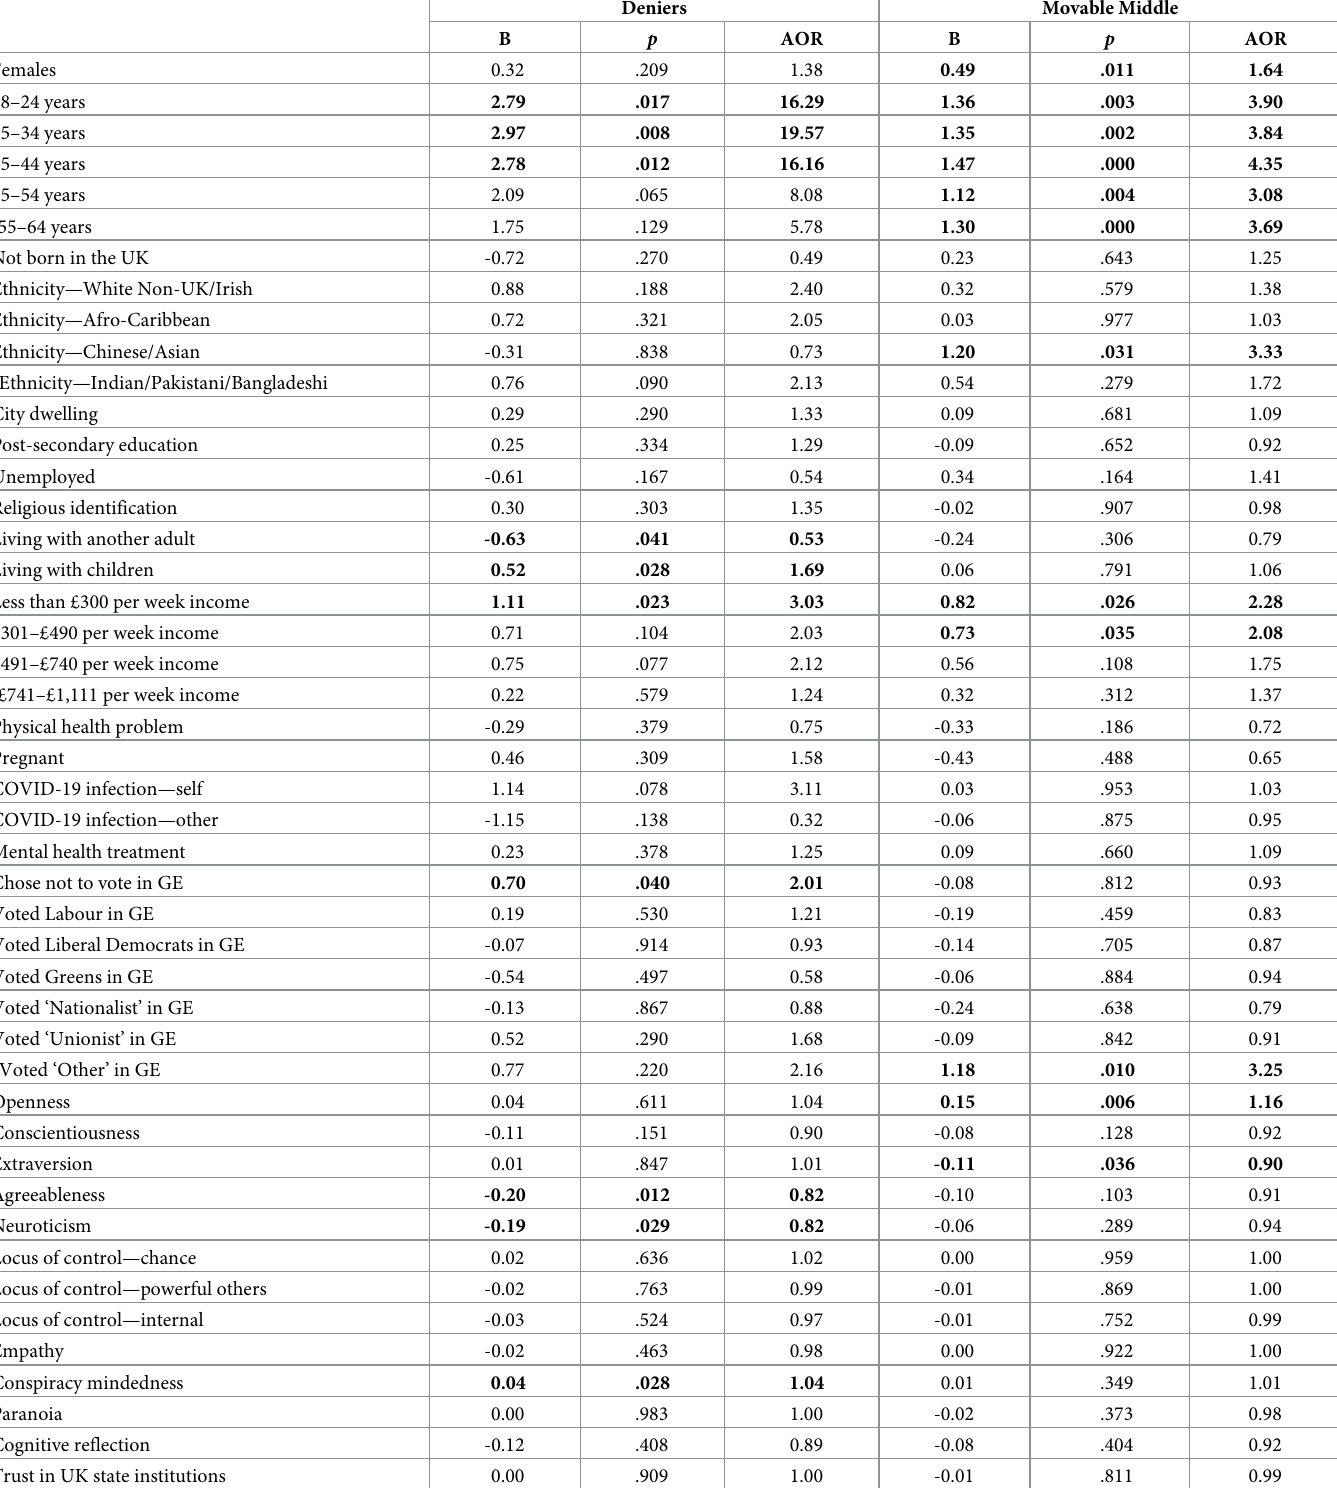
Table 5. Correlates of class membership in the UK sample (N =